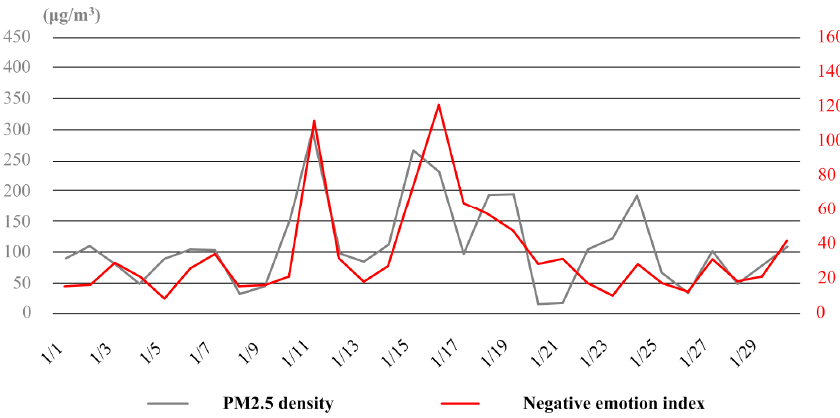
Figure 9. The variation curves of PM2.5 density and negative emotion index in January.